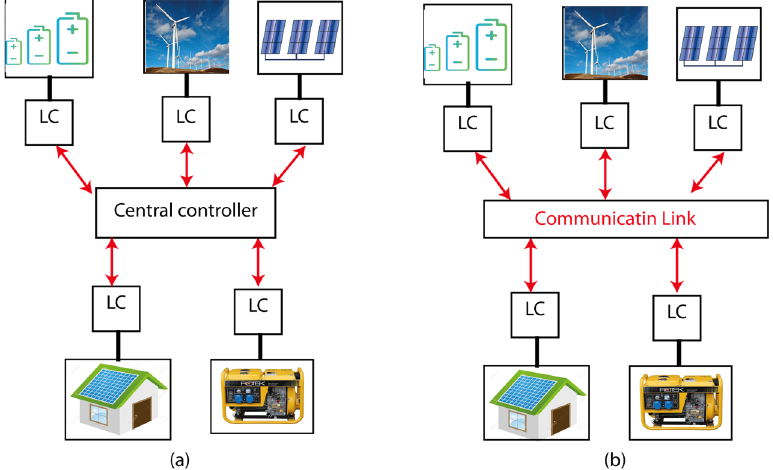
Figure 2. ( a ) Centralized and ( b ) decentralized control structure.